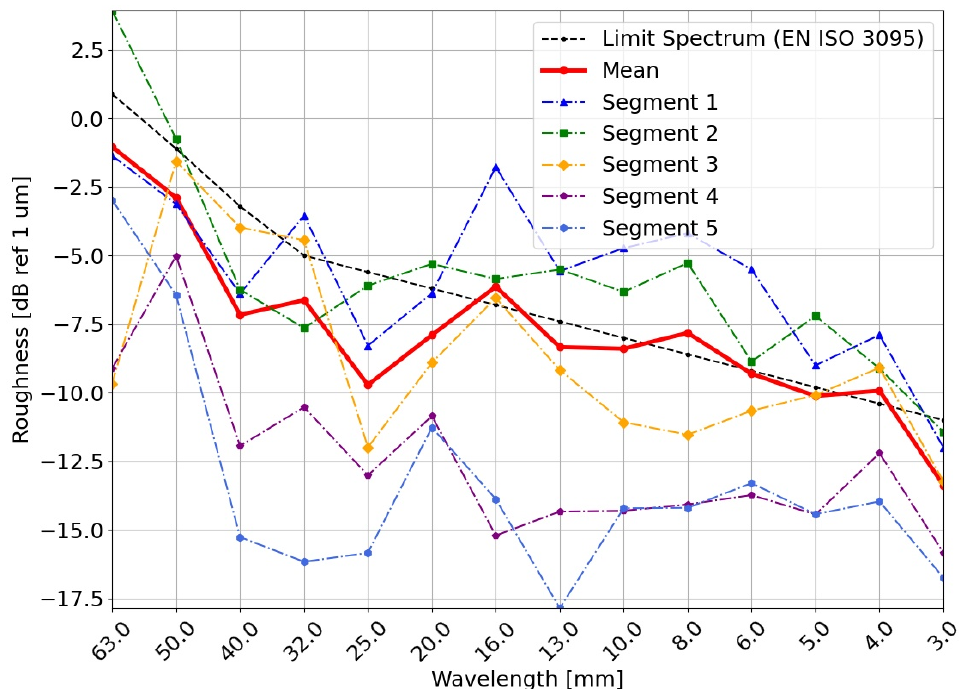
Figure A5. Spectrum of acoustic roughness for five adjacent measurements and the evaluated mean of the optical system in the tunnel and the limit spectrum from EN ISO 3095 [22].